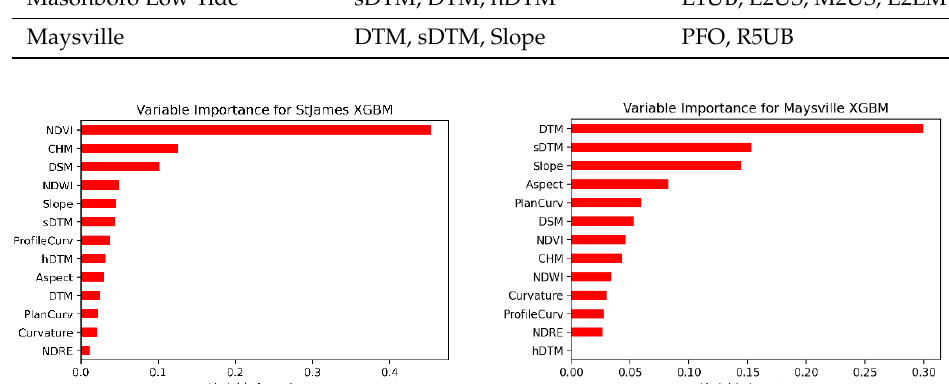
Figure 4. Feature importance for the XGBM Models of St. James and Maysville.